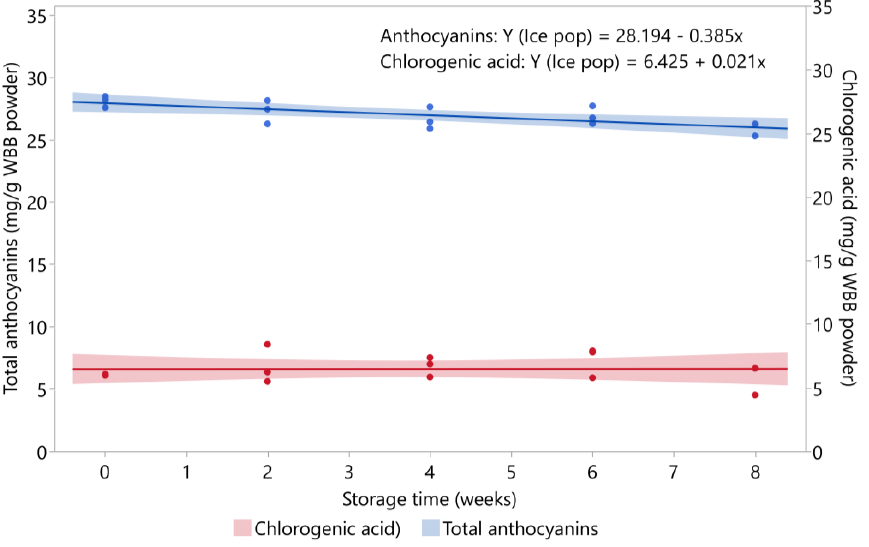
Figure 1. Stability of total anthocyanins and chlorogenic acid in ice pop stored at − 20 °C ( n = 3/time point). Shaded area around lines represents 95% confidence intervals for predicted values.